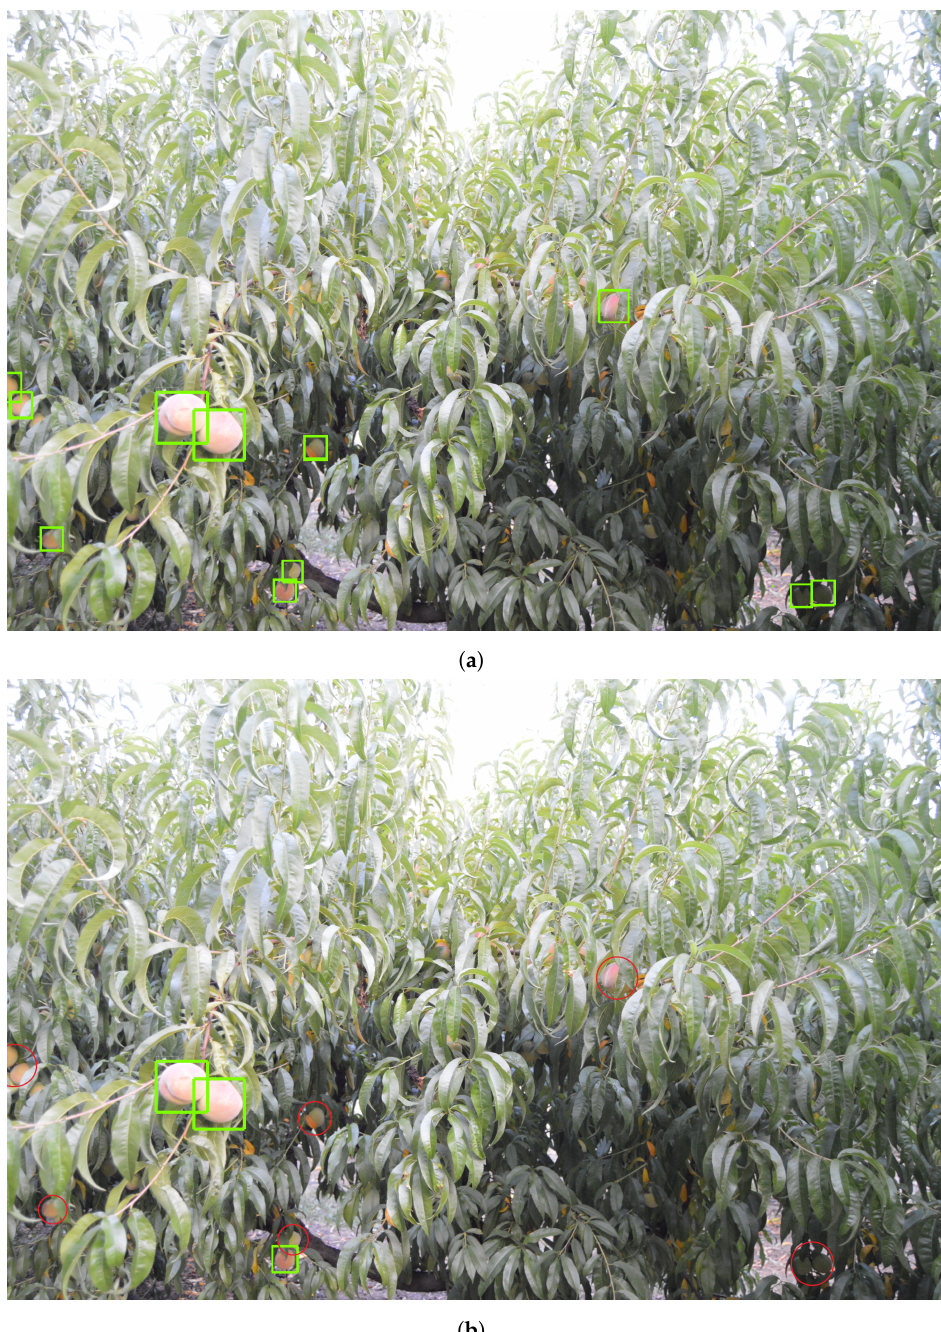
Figure 11. Test result in a different orchard (sample-2): ( a ) shows a test image and its manually annotated fruits; ( b ) shows the predicted fruit detection by the model. The green rectangular boxes are corrected detections, and the red circles are illustrative missing